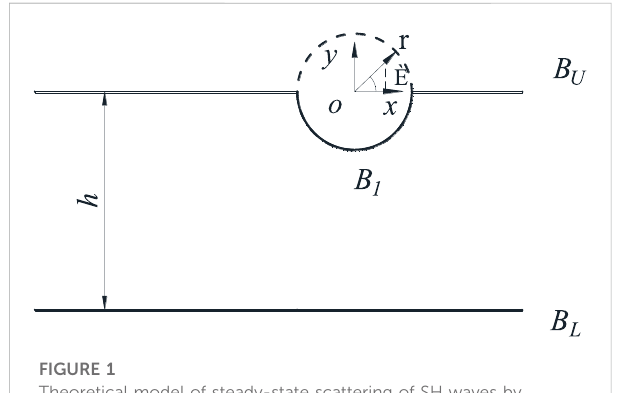
FIGURE 1 Theoretical model of steady-state scattering of SH waves by semi-cylindrical depressions in elastic ribbon